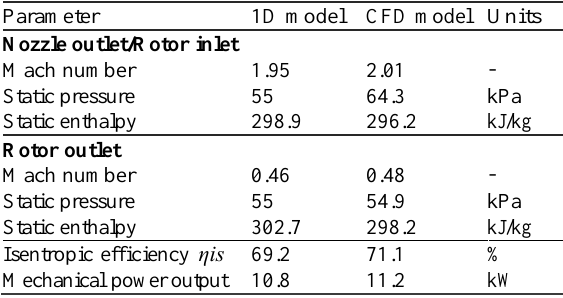
Table 3. Comparison of the achieved parameters inbetween the 1D meanline model and the CFD